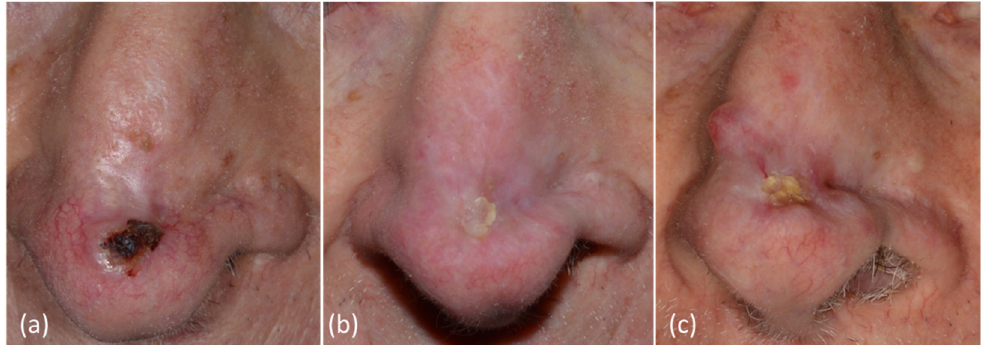
Figure 2. Patient/tumor 12 (Table S1, Supplementary Materials). ( a ) Basal cell carcinoma relapse after surgery in an 86–year-old patient at baseline. ( b ) Twelve months after initiation of immunocryosurgery treatment cycles: partial response; ( c ) At 44 months of follow-up: slow disease progression. At this point, the already 90–year-old patient denied any further therapeutic interventions.